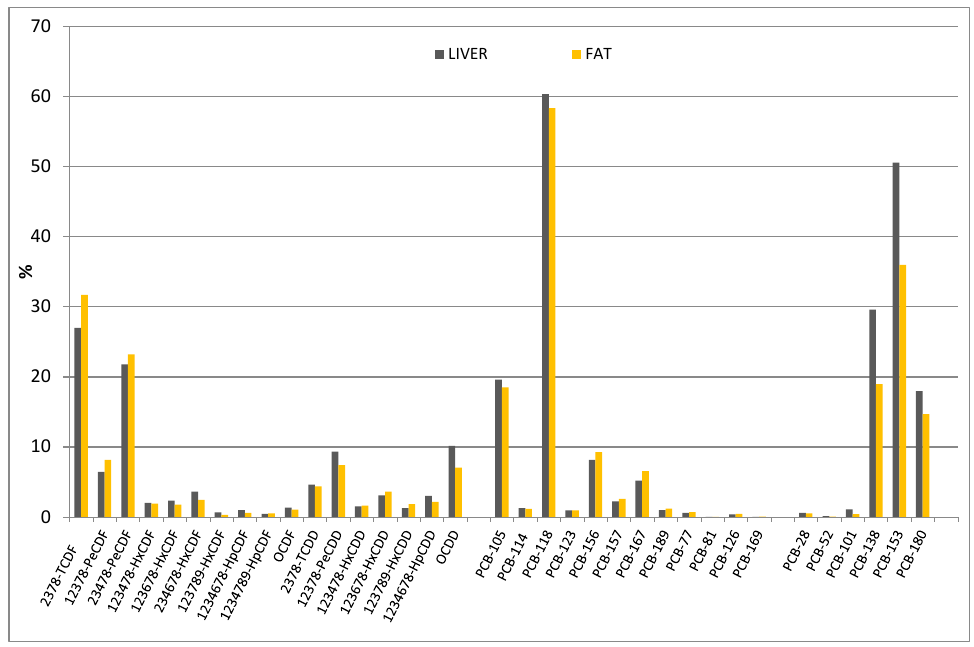
Figure 1. PCDD/Fs-, DL-PCBs-, and NDL-PCBs-normalized congener patterns in liver and fat tissue. Each pattern was normalized for the sum of the congeners of the respective class of contaminants.